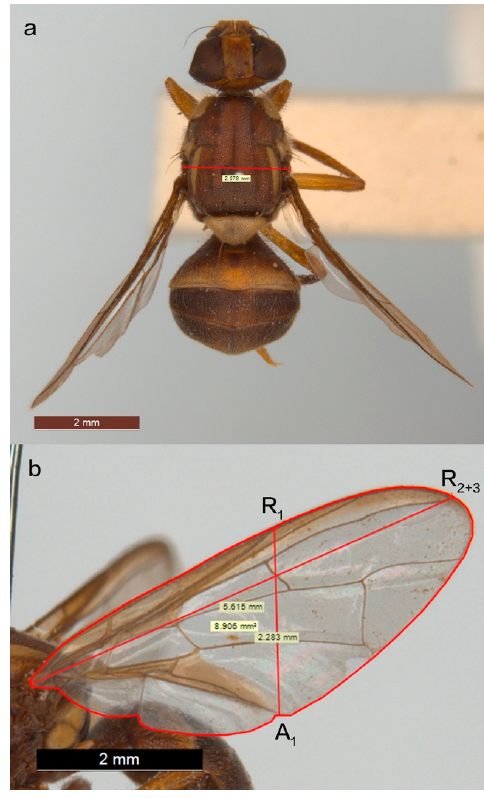
Figure 2. Measurements: ( a ) Intertegular length (a proxy for body size). The red line shows the intertegular length in a Q-fly; ( b ) wing length, width, and area measurements. Wing length was measured from the base of the wing to the end of vein R 2+3 , wing width was measured from the end of vein A 1 to the end of vein R 1 , and the area of the wing was measured by outlining the edge of the wing.